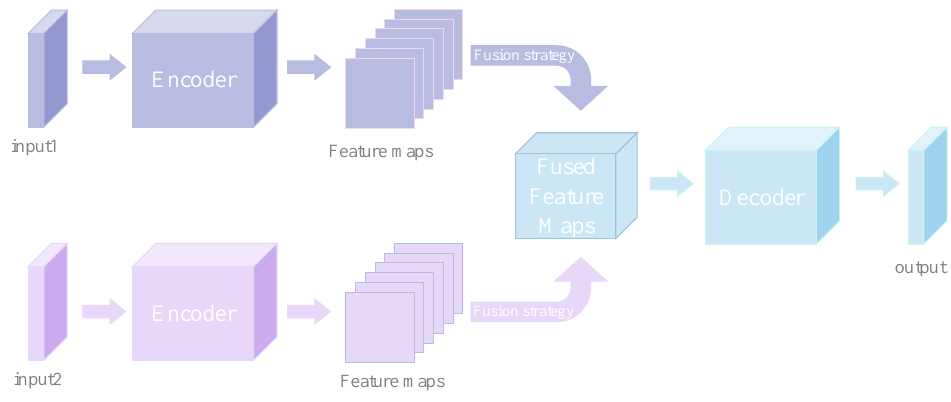
Figure 2. The Architecture of Network